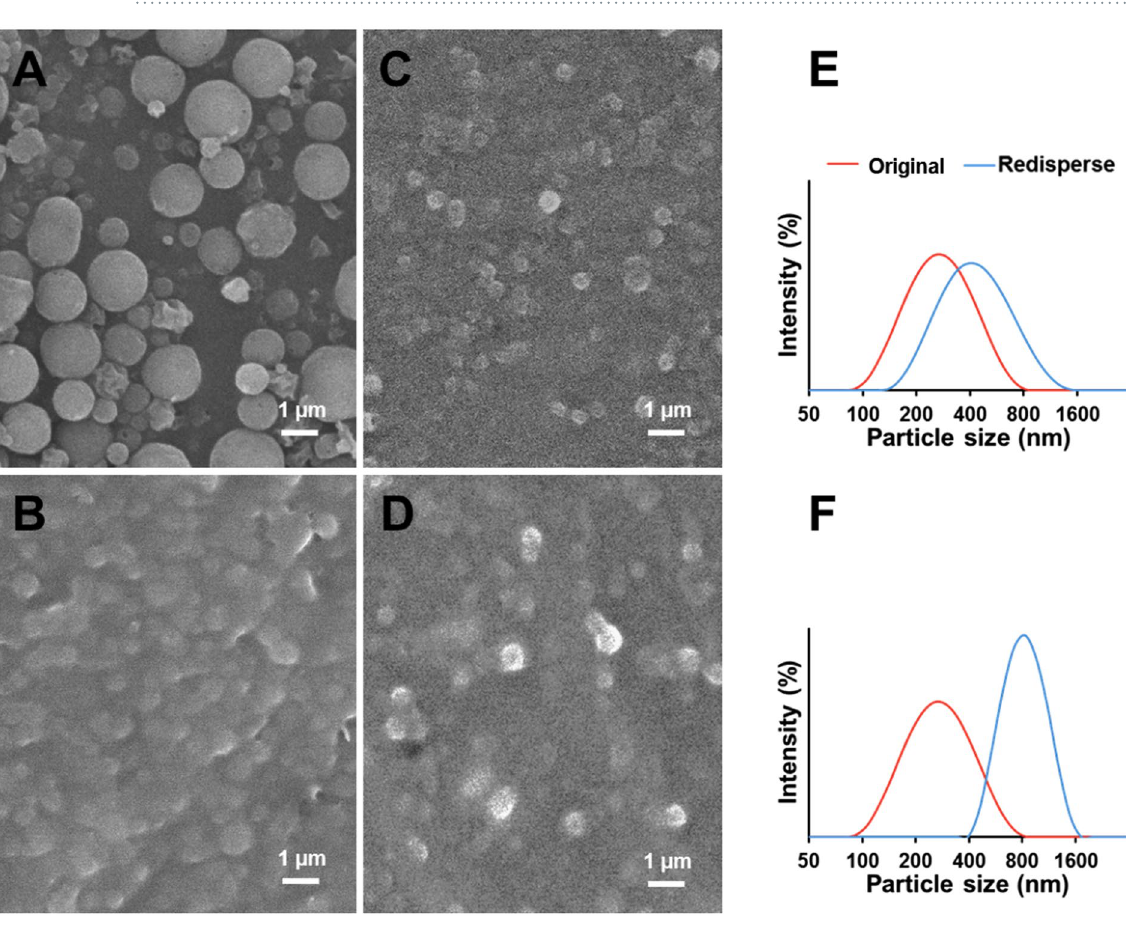
(Fig. 11C), comparing to their original size of 252 nm, suggesting that some irreversible aggregation occurred during drying process. Interestingly, the freeze-dried LPN (Fig. 11B) did not show a significant change in particle size in dry powders and redispersed colloidal LPN (Fig. 11D), both of which were around 500 nm. While the redispersed freeze-dried colloidal LPN were larger than the original LPN, they were much more homogeneously distributed with a dramatically smaller PDI and a narrower distribution curve (Fig. 11E and F). Spray drying and freeze-drying are the two most commonly used drying techniques to transform colloi- dal nanoparticles to dry powders. Spray drying technique, characterized by fast water removal rate via heating